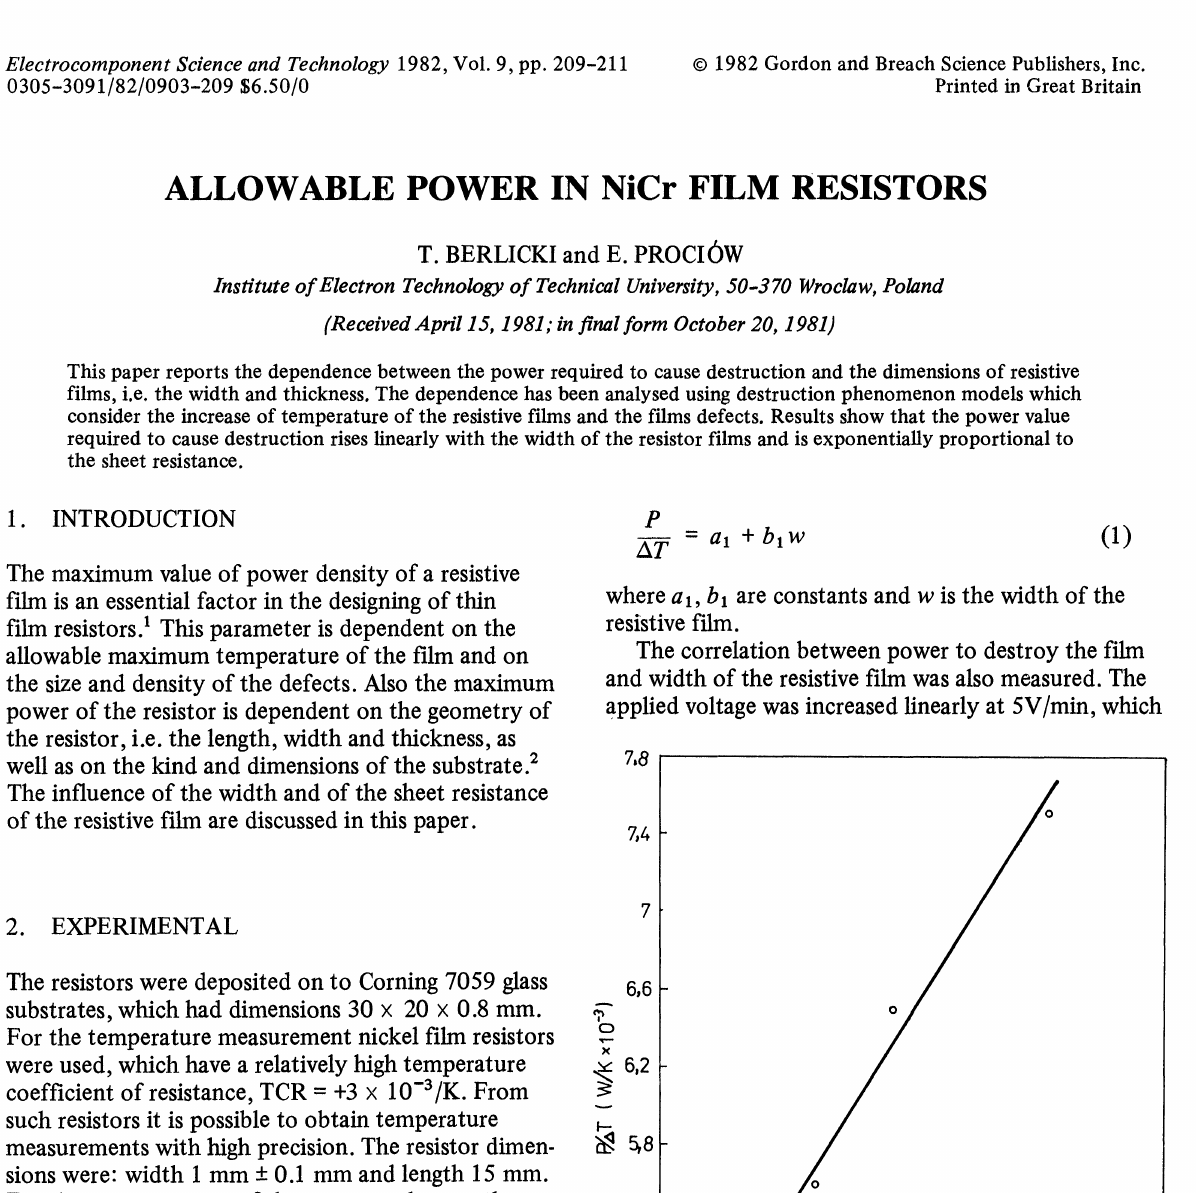
0,2 0,4 0,6 0,8 1,2 W (mm) FIGURE Thermal conductance as a function of the width of a resistive film.